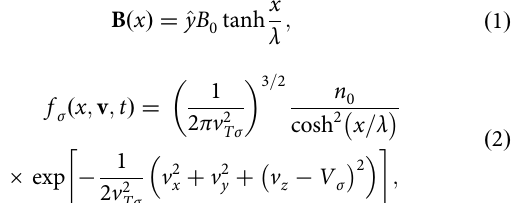
Figure 1 summarizes the four classes of particle orbits. The black lines in Fig. 1a – d show the effective potential χ of each